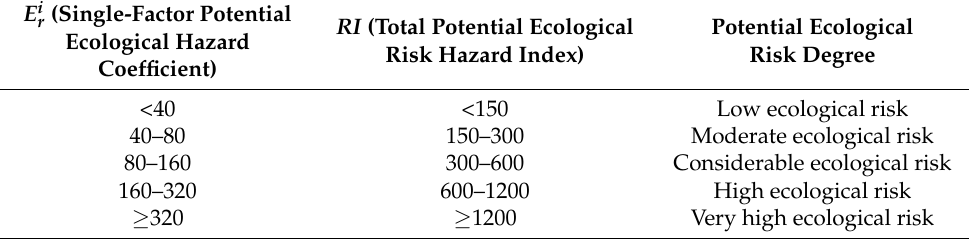
Table 3. Potential ecological risk assessment indices and their classifications. E i r (Single-Factor